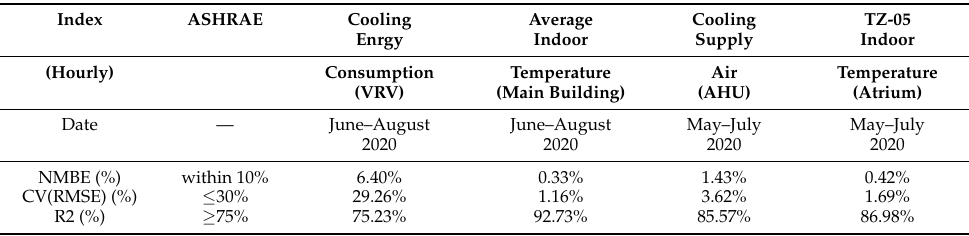
Table 3. Results of Variable Refrigerant Volume (VRV) and Air Handling Unit (AHU) system evaluation for cooling period, June to August